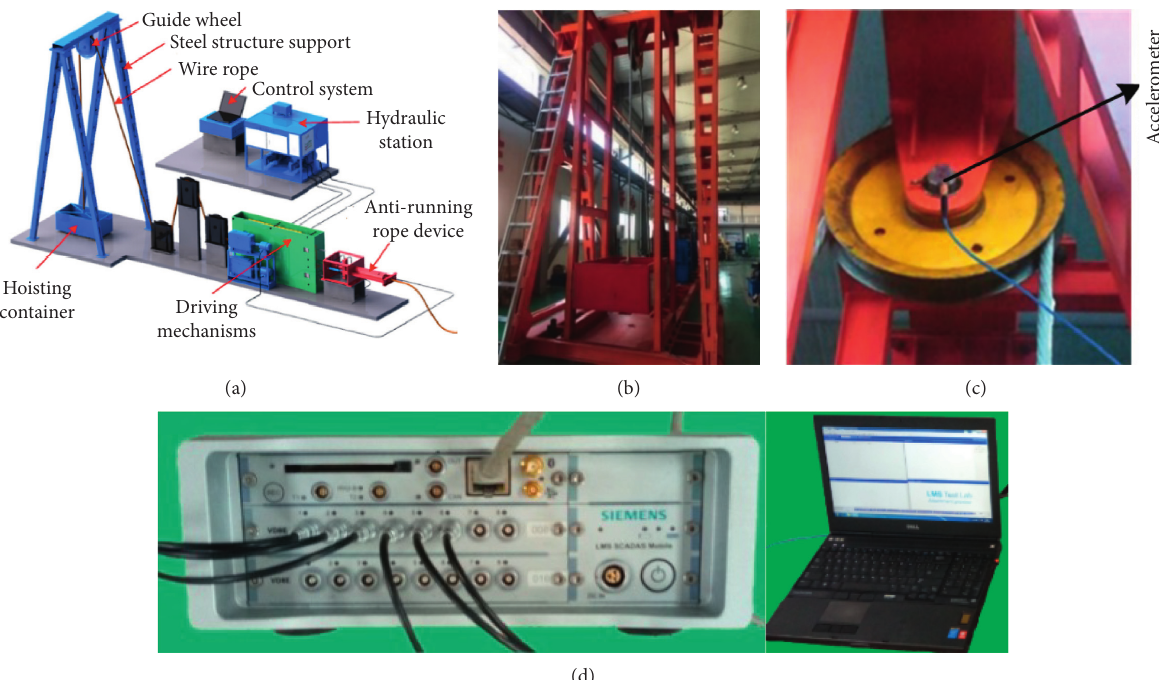
Figure 12: Hoist simulation testing setup: (a) equipment diagram; (b) physical map; (c) sensor’s fixed position; (d) data acquisition equipment.